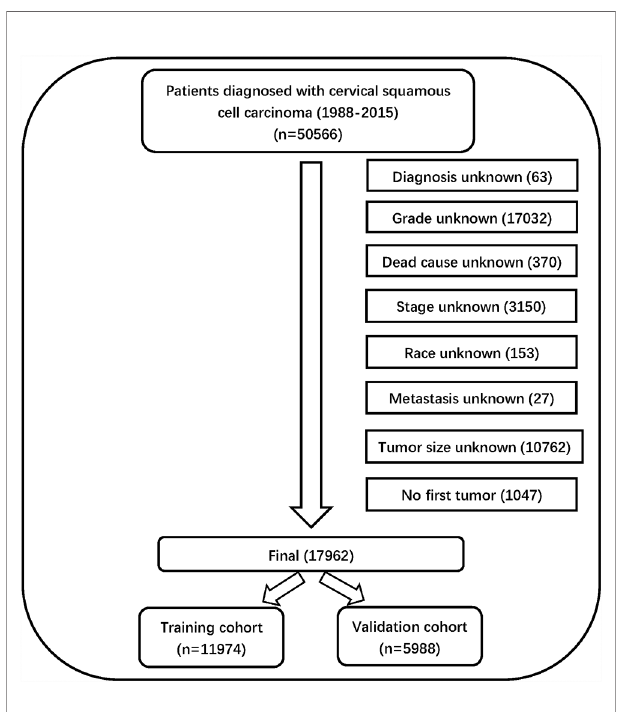
FIGURE 1 | Chart of the data fi ltering process and grouping